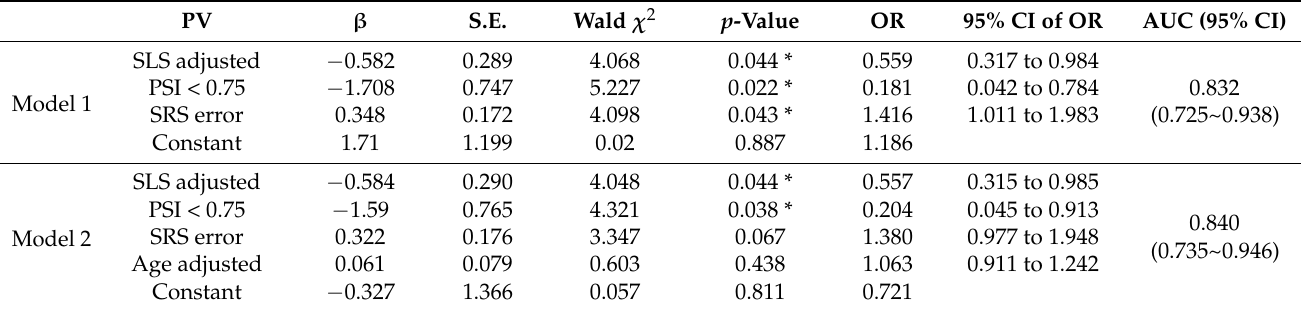
Table 6. Logistic regression characteristics, models 1 and